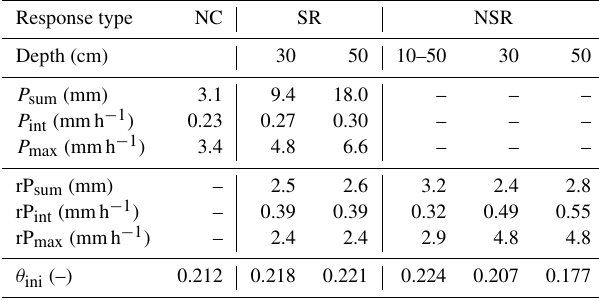
Table 4. Rainfall characteristics of the different infiltration types and their corresponding depths (median values of all profiles and events). Sequential response (SR) with maximum response depth (cm) and non-sequential response (NSR) with depth of first out- of-sequence response (cm). Rainfall variables were calculated for the entire event ( P ) and also for the time prior the first (out-of- sequence) sensor response (rP).